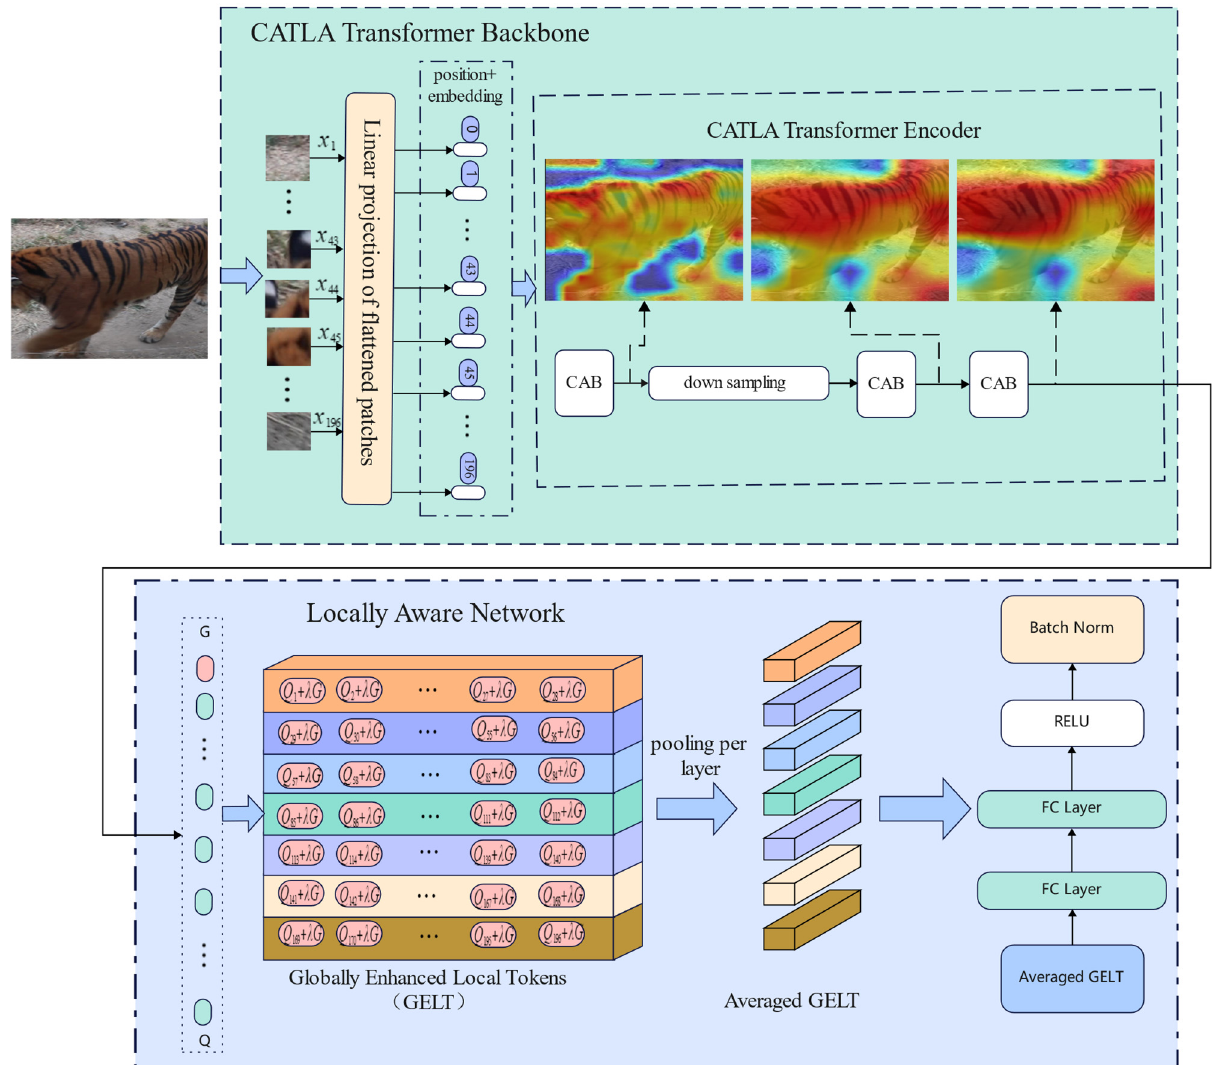
Figure 3. The overall pipeline of our approach (the input image is 224 × 224, and the patch is 16 × 16, so 196 local tokens will be generated). The generated tokens F = f_0, f_1, . . . , f_196, where f_0 is the global token. The global token is called G, and the local tokens are called Q. The global and local tokens are combined using a weighted-average method and arranged into a 7 × 28 2D distribution. Each layer is pooled and finally fed into the classifier.